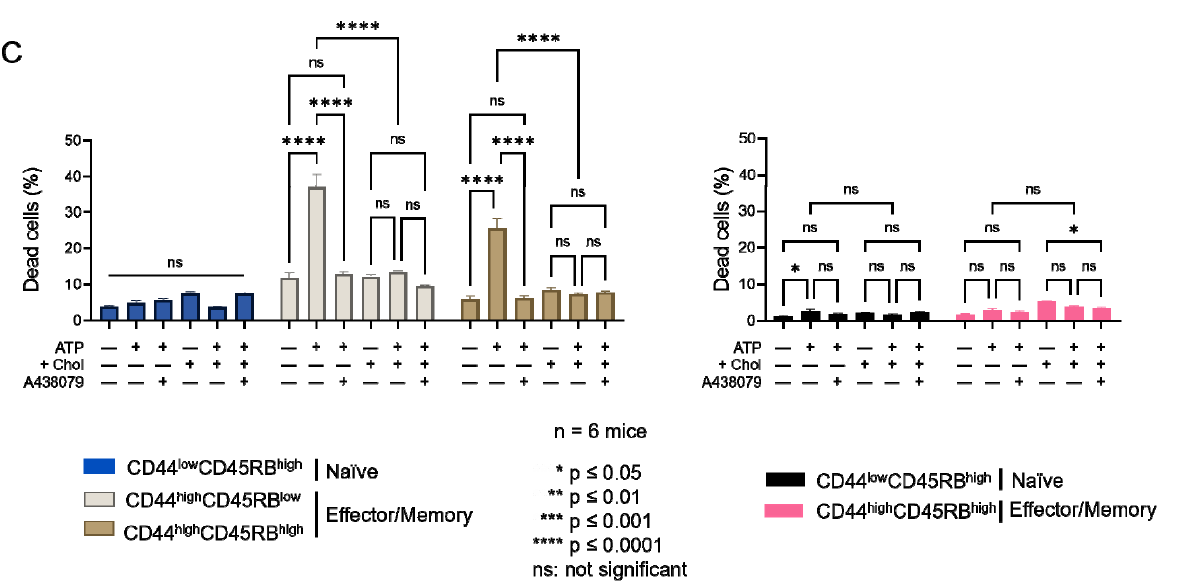
Figure 3. Amplitude of P2X7-induced cellular responses in T cells following plasma membrane cholesterol modulation. Amplitude of P2X7-mediated pore formation ( A ), CD62L shedding ( B ) and cell death ( C ) were evaluated among CD44 low CD45RB high naïve and CD44 high CD45RB low or CD44 high CD45RB high effector/memory CD4 + and CD8 + T-cell subsets in the presence of 500 µ M eATP for 30 min at 37 ◦ C with or without pre-treatment with 10 µ M of the P2X7 antagonist A438079 (+A438079), following ex vivo plasma membrane cholesterol enrichment using MBCD/Chol complexes. Data are expressed as the mean of percentages ( ± SEM, n ≥ 6 mice). Asterisks denote statistically significant differences * p ≤ 0.05, ** p ≤ 0.01, *** p ≤ 0.001, **** p ≤ 0.0001, ns: not significant.